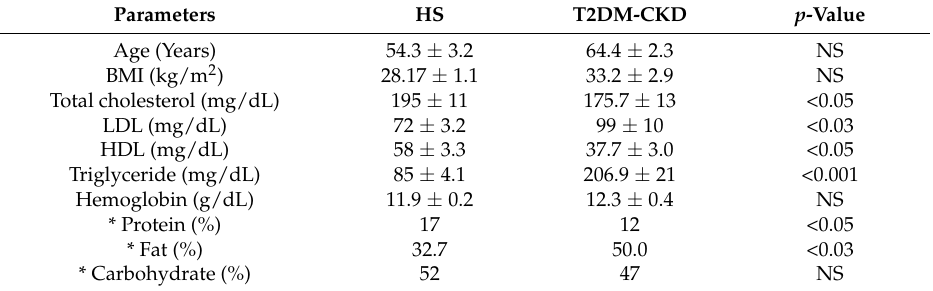
Table 1. Anthropometric and metabolic parameters in the study groups. The measurements presented as mean ± SEM. NS: non-significant, BMI: Body Mass Index, LDL: Low-Density Lipoprotein, HDL: High-Density Lipoprotein, the asterisk (*) indicates the diet.